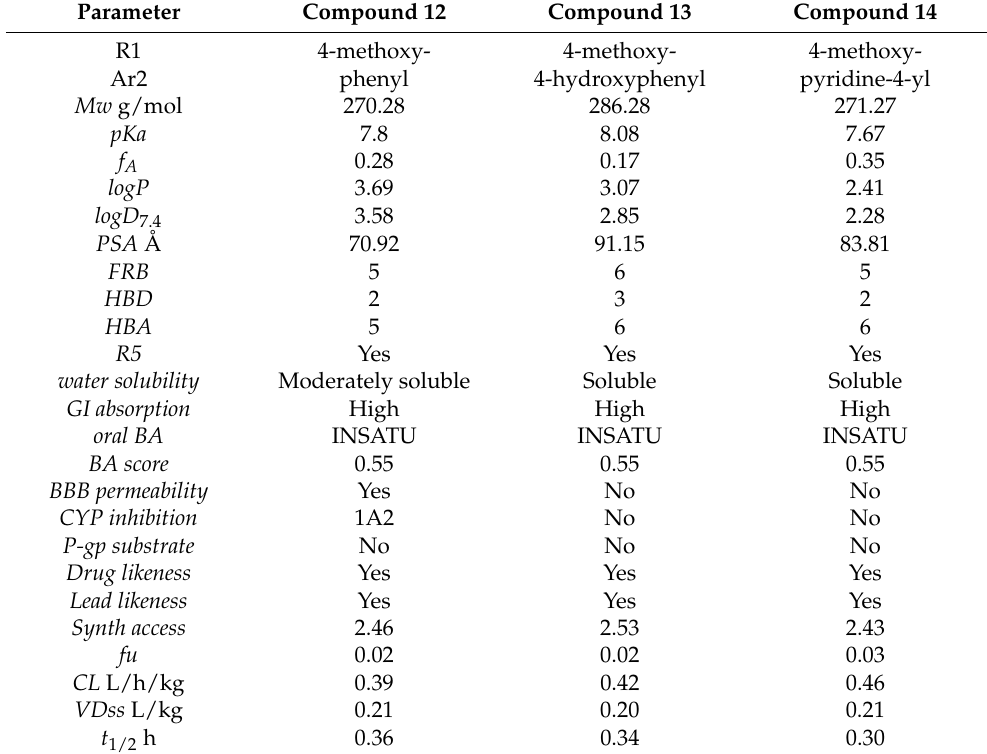
Table 3. Physicochemical and ADME properties and pharmacokinetic parameters of 4-metoxysalicylic hydrazones. Parameter Compound 12 Compound 13 Compound 14 R1 4-methoxy-